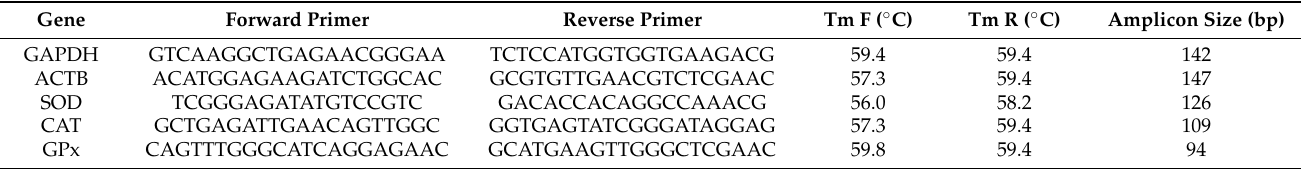
Table 2. Primers used for quantitative real-time PCR analysis of gene expression in the liver and L. dorsi muscle of this